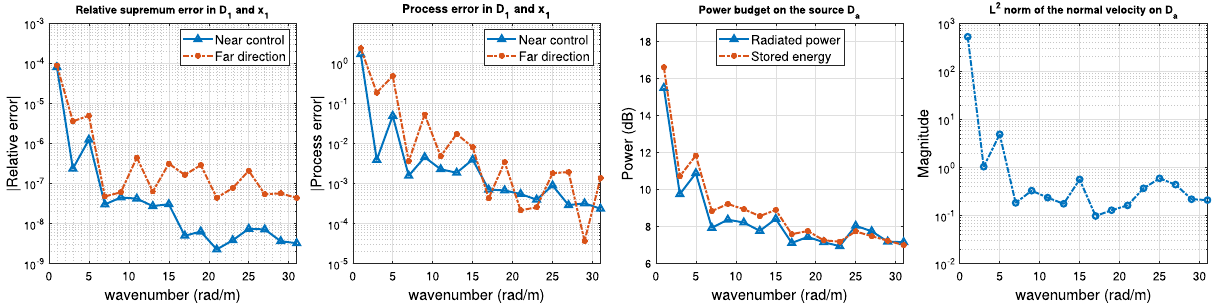
Figure 9. Results showing the control accuracy and the power budget varying with k . From left to right, (1) Supremum error. (2) Process error. (3) Power budget on D a . (4) L 2 norm of normal velocity v n on D a